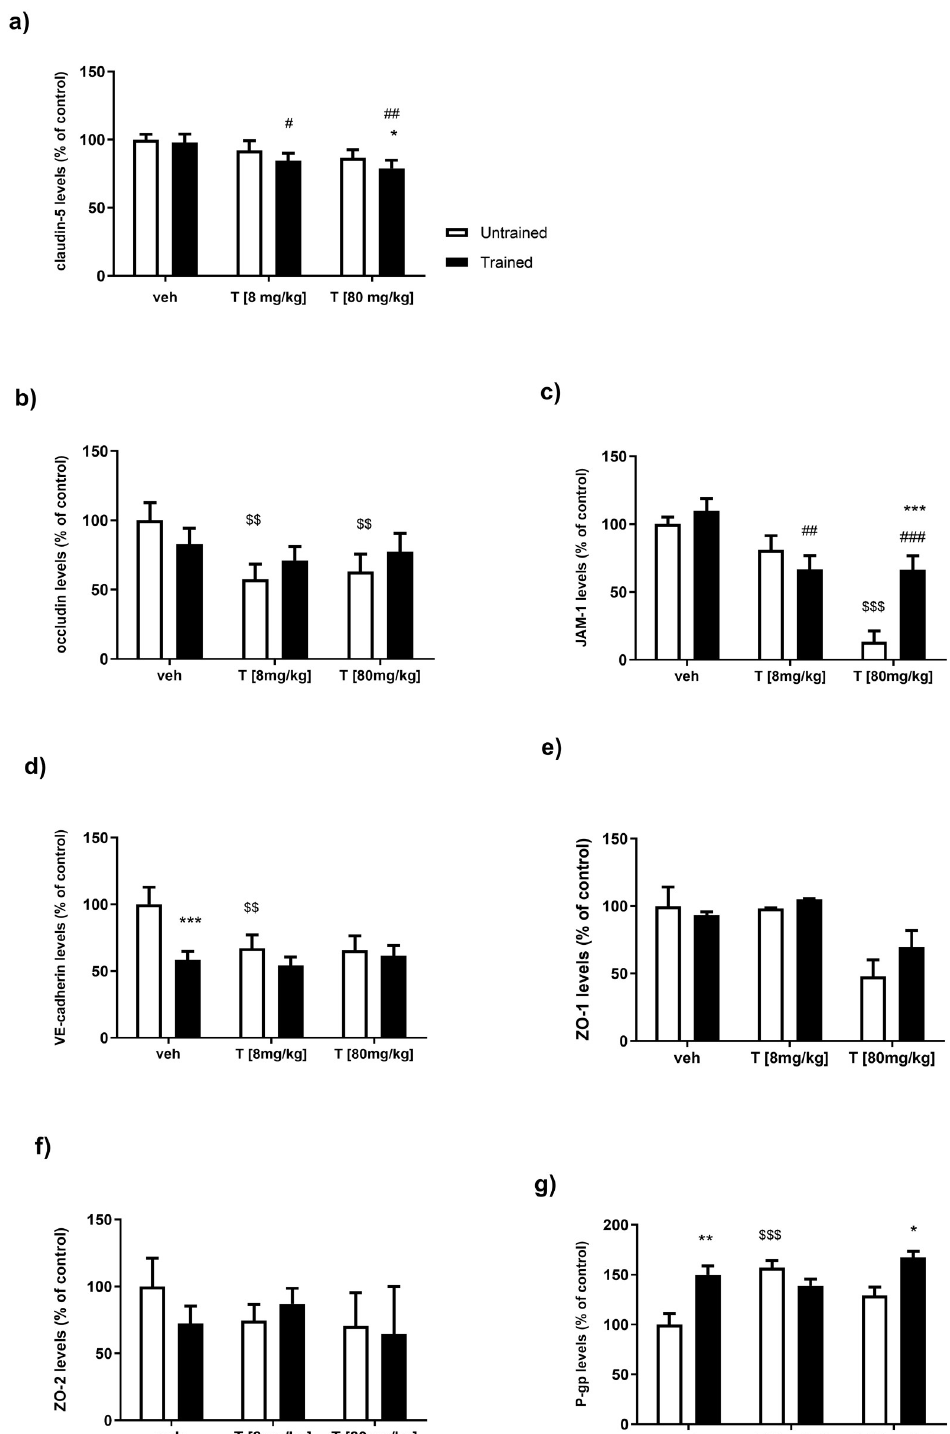
Fig 2. The effect of endurance training and/or testosterone administration on: a) Claudin-5 levels in the spinal cords of male rats. Values are expressed as a percentage of the control. Data were analyzed with a two-way ANOVA and post-hoc Tukey’s test. # p = 0.024 and ## p = 0.0018 vs. Tr � p = 0.025 vs. TrT [80 mg/kg]. b) Occludin levels in the spinal cords of male rats. Values are expressed as a percentage of the control. Data were analyzed with a two-way ANOVA and post-hoc Tukey’s test. $ $ p = 0.0032 (for T [8 mg/kg]) vs. Veh, $ $p = 0.0095 (for T [80 mg/kg]) vs. Veh.